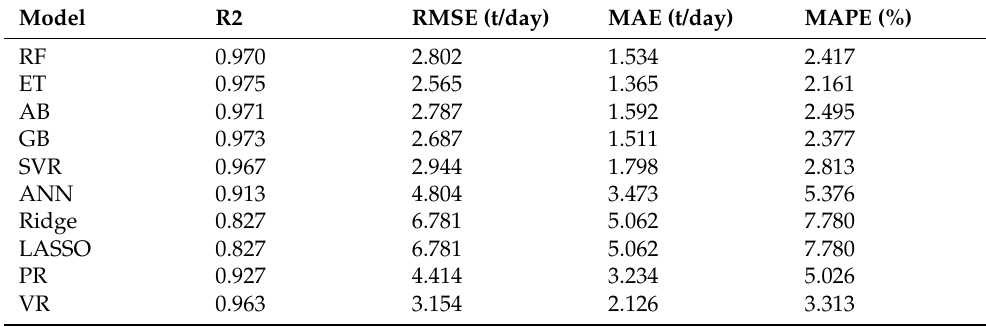
Table A2. Fuel consumption prediction accuracy of different machine learning models on the test set.